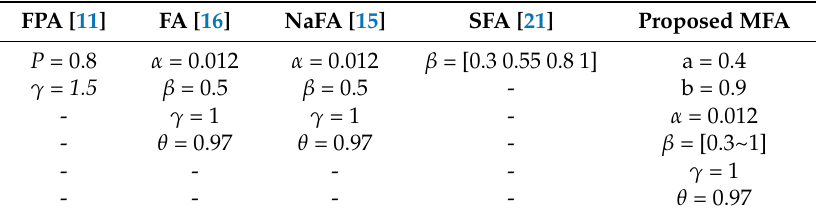
Table 3. Parameter settings of the flower pollination algorithm (FPA), firefly algorithm (FA), NaFA, SFA, and the proposed